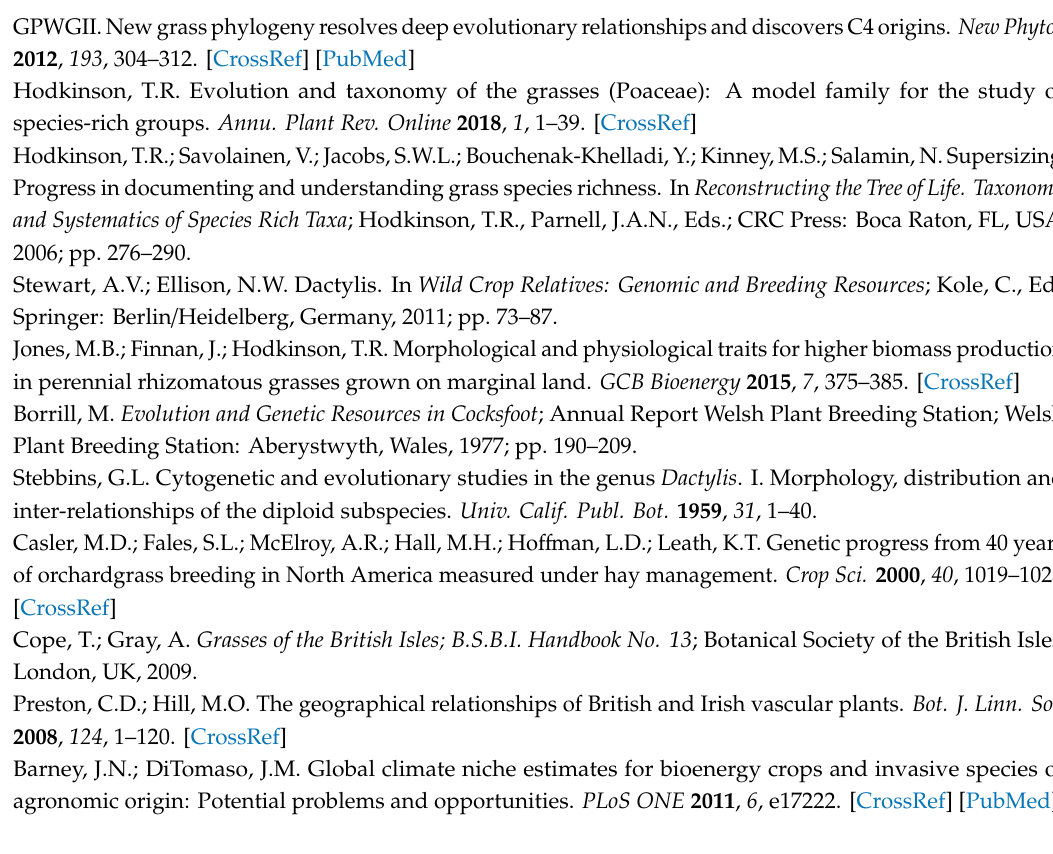
Figure S1: Optimal value of K determined by the ∆ K statistic using Structure Harvester. Eight clusters were determined as optimal, Figure S2: Structure of Dactylis glomerata genotypes estimated using structure analysis of plastome SNPs with K = 5 instead of the optimal value of K = 8. The K = 8 plot is presented in the main text. Each plant is shown as a vertical bar and SNP variation is partitioned into coloured segments that show the individual’s estimated membership fractions in each of the K = 5 clusters. K = 8 was determined as optimal by the ∆ K statistic. Alternative cluster numbers were compared but we have no a priori evidence to accept any of these nor do they alter our interpretation of the results based on the optimal value of K = 8. We present K = 5 here as an example of results with an alternative K value. K = 5 was chosen a priori, instead of other alternative K values (e.g., 2, 3, 4, 6, 7), based on the artificial but rough geographical proximity of groups (national boundaries). Samples are arranged in the plot according to geographic location (1 = Poland, 2 = Germany, 3 = Denmark, 4 = Sweden, and 5 = Ireland, 6 = UK combined; total K = 5). Table S1: Long-read PCR parameters for each primer pair, Table S2: Flow cytometry and ploidy determination results for Dactylis glomerate